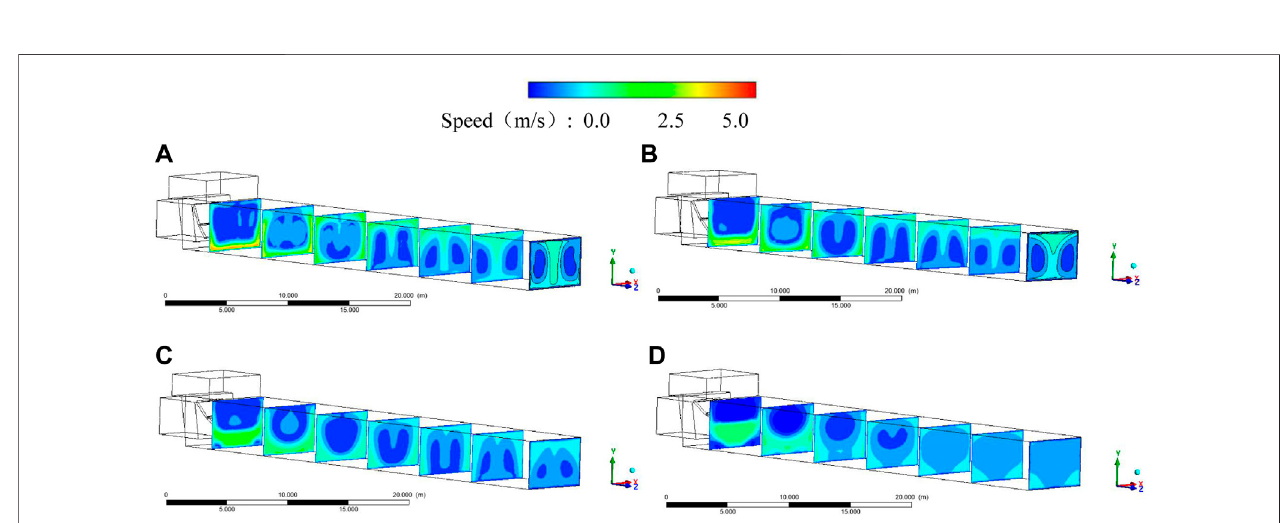
FIGURE 8 | Flow fi eld distribution of axial sections: (A) case 1, (B) case 2, (C) case 3, and (D) case 4.